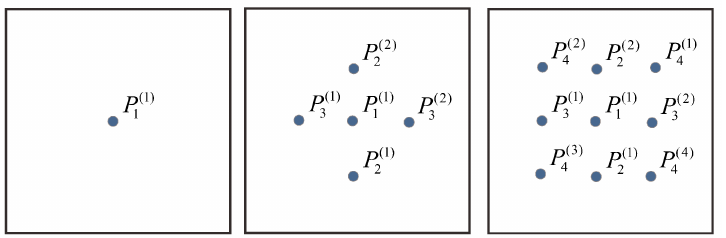
Figure 12. Three different damping configurations.